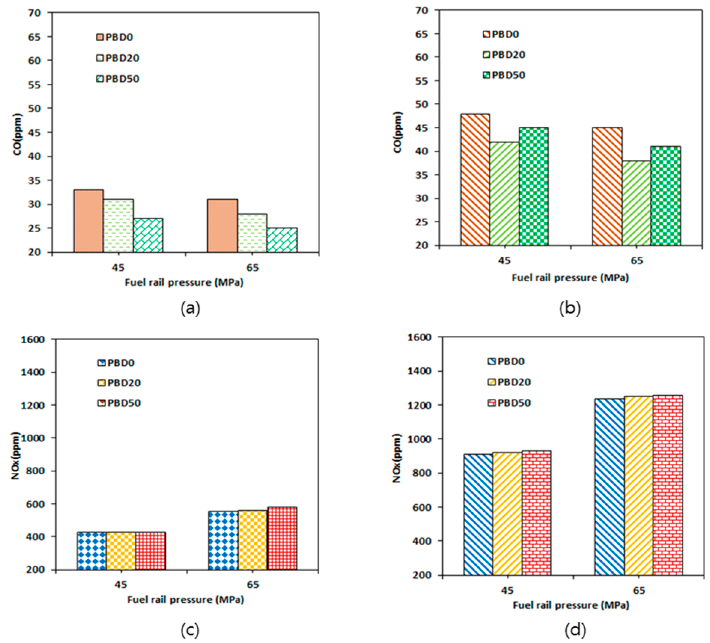
Figure 10. Exhaust gas emissions of CO from engine loads of ( a ) 50 Nm and ( b ) 100 Nm and NOx from engine loads of ( c ) 50 Nm and ( d ) 100 Nm. 344